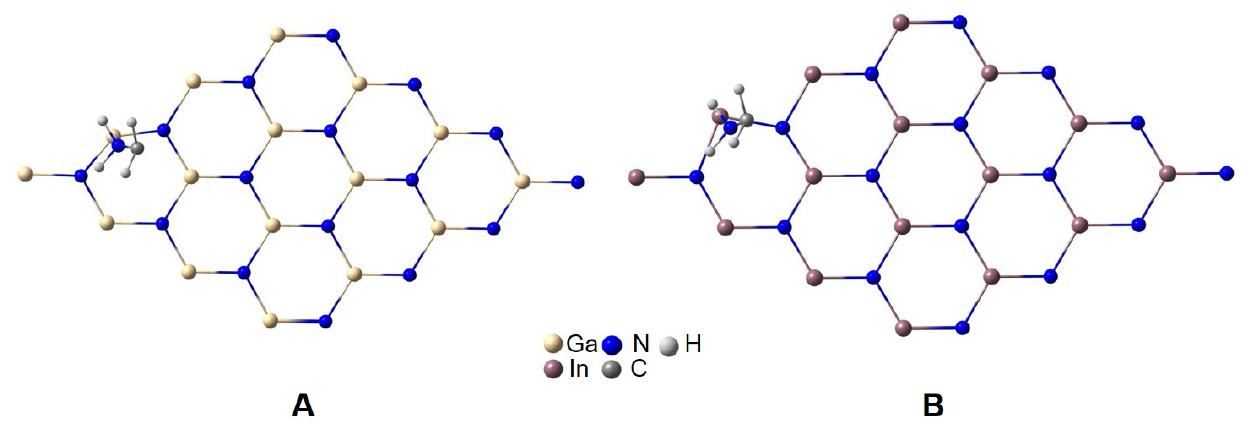
Figure 3. Optimized structures for position 1 for GaN-DDA ( A ) and InN-DDA ( B ) systems.